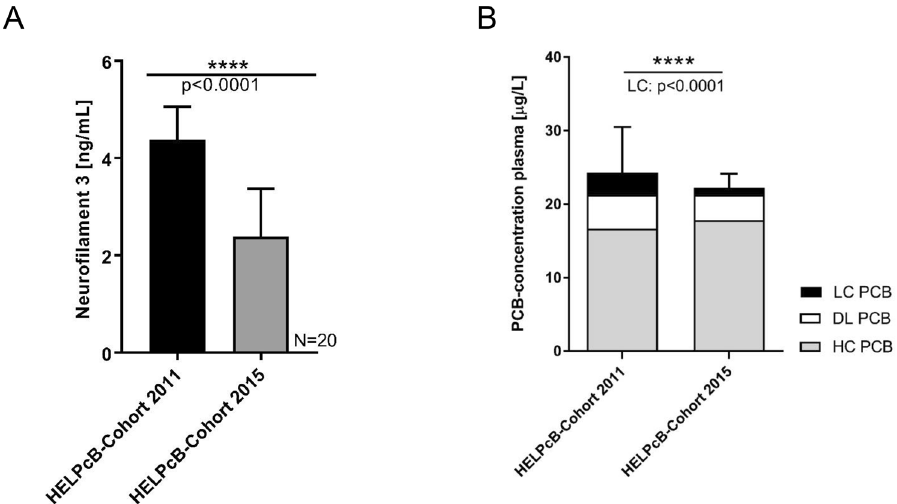
Figure 5. Neurofilament light chain levels in PCB exposed individuals. ( A ) Quantification of the neurofilament light chain in longitudinally collected plasma samples from the HELPcB-Cohort (N = 20 per time point; each with two technical replicates). ( B ) Mean plasma levels for Σ higher chlorinated PCBs (grey), Σ dioxin-like PCBs (white) and lower chlorinated PCBs (black) from longitudinally collected samples (HELPcB-Cohort). Differences were calculated by ANOVA and adjusted by posthoc Tukex-test for multiple measures. Statistical differences are as indicated ****p ≤